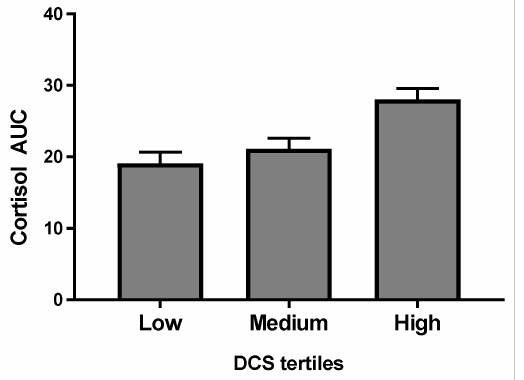
Figure A3. Age and sex-adjusted geometric means of LNSC, morning after awakening (M1) cortisol, and total cortisol output calculated by